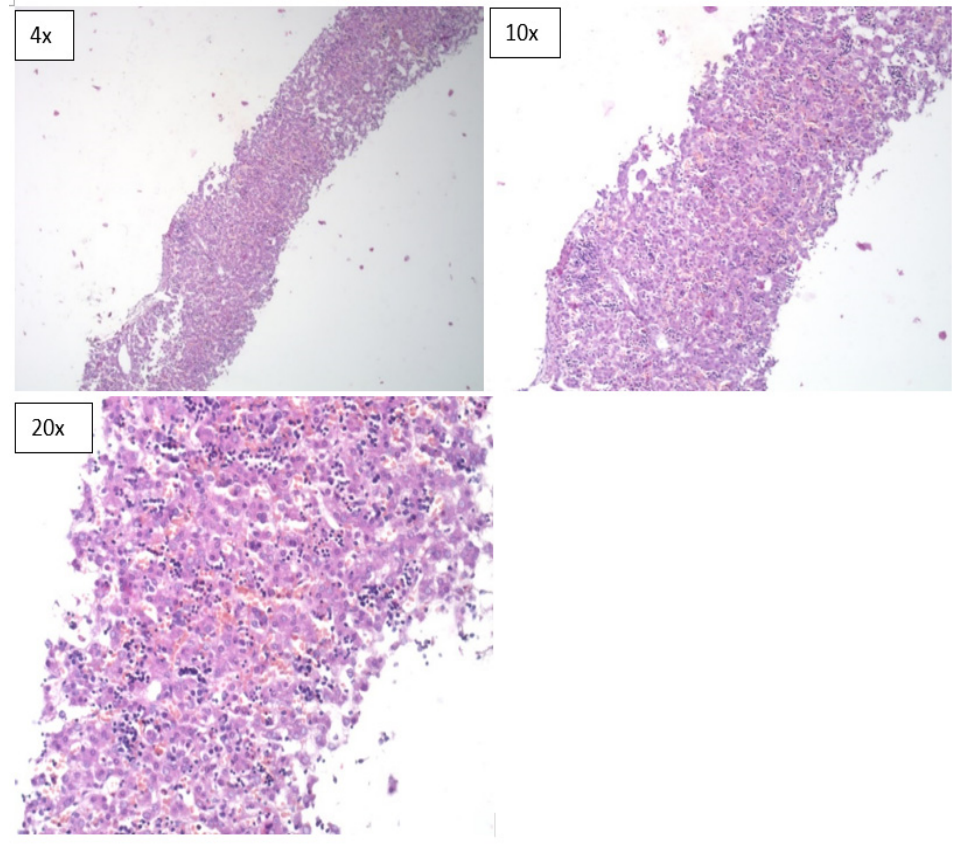
Figure 3. Microscopic sections of liver tissues obtained during the MITS procedure (H & E).